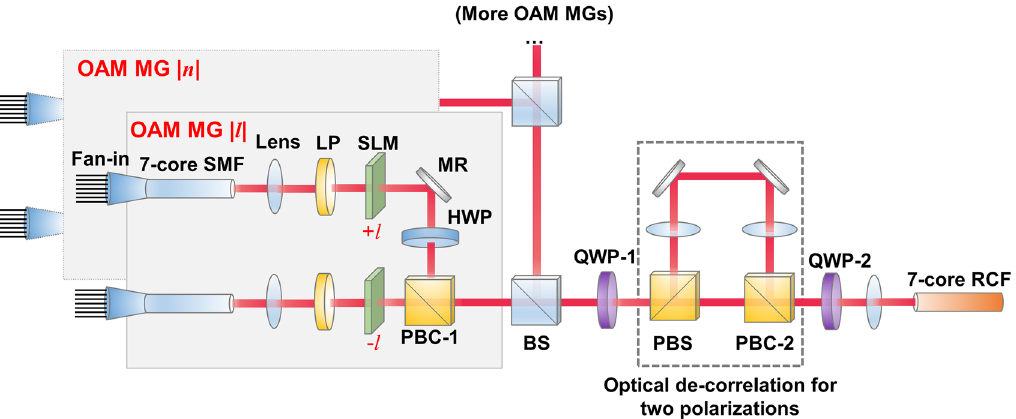
Figure 5: Experimental setup of the seven-core multi-mode multiplexing system. Multiple ‘ 7-to-7 ’ branches are used to excite different OAM modes and are combined by the beam splitters. The setup is scalable by constructing more ‘ 7-to-7 ’ branches. A polarization multiplexing module is constructed to optical de-correlate for two orthogonal polarizations.SMF,single-modefibre;LP,linearpolarizer;SLM,spatiallightmodulator;MR,mirror;HWP,half-waveplate;QWP,quarter-wave plate; BS, beam splitter; PBS (PBC), polarization beam splitter